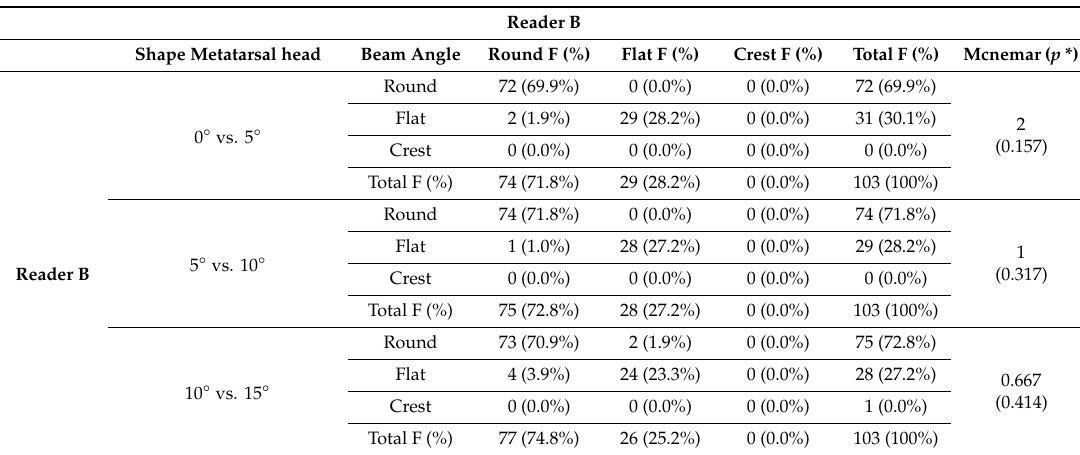
Table 3. Intraobserver B agreement about shape first metatarsal head in beam angle: 0 ◦ vs. 5 ◦ , 5 ◦